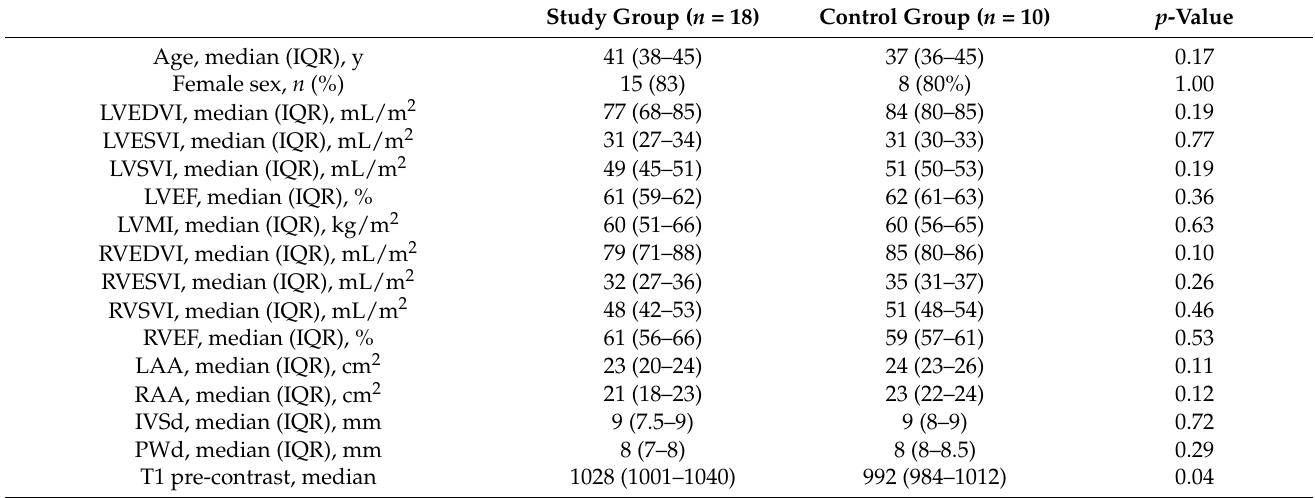
Table 2. Cardiac MR